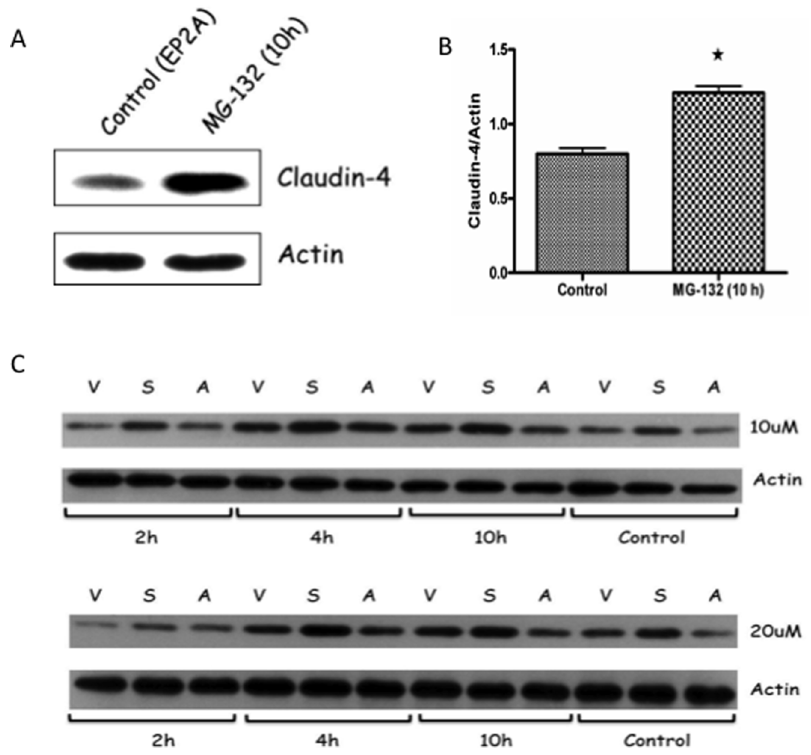
Figure 4. Claudin-4 undergoes increased proteosomal degradation in EP2A cells. (A) EP2A cells grown as monolayer on culture plates were exposed with 20 m M of MG-132 (proteosomal inhibitor) for 10 h. Cells were collected and checked for claudin-4 expression by western blotting. Actin used as internal control protein. (B) The corresponding densitometry analysis for claudin-4 expression, w p , 0.05. (C) Western blots depicting dose and time response of MG-132 treatment on claudin-4 expression in vector control, EP2S and EP2A cells. Two different doses of MG-132 (10 and 20 m M) exposed for 2, 4 and 10 h time period were studied. Control cells were exposed with only DMSO (diluent for MG-132) for 10 h. V=vector control; S=EP2S;